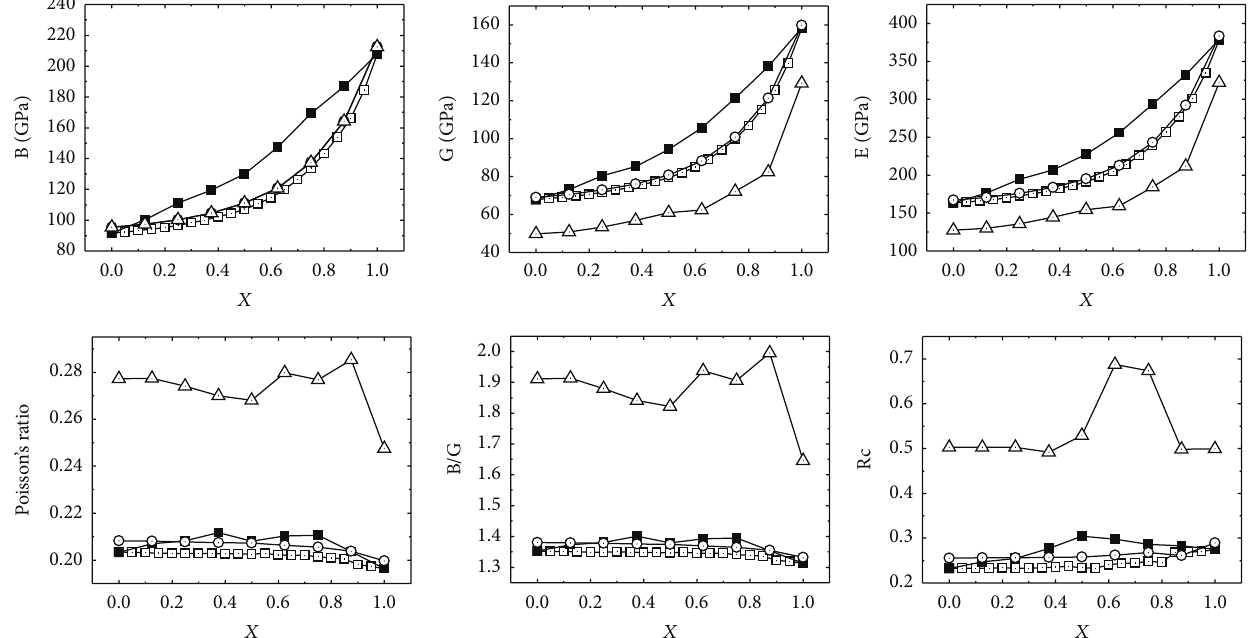
Figure 4: Composition dependence of the related elastic parameters in the wurtzite (WZ) structure. Each graph presents one parameter calculated using all the methods. Filled points represent the supercell (SC) alloy simulation while empty points represent the alchemical mixing (AM). Squares: finite difference method, circles: clamped case of DFPT, and triangles: relaxed case of